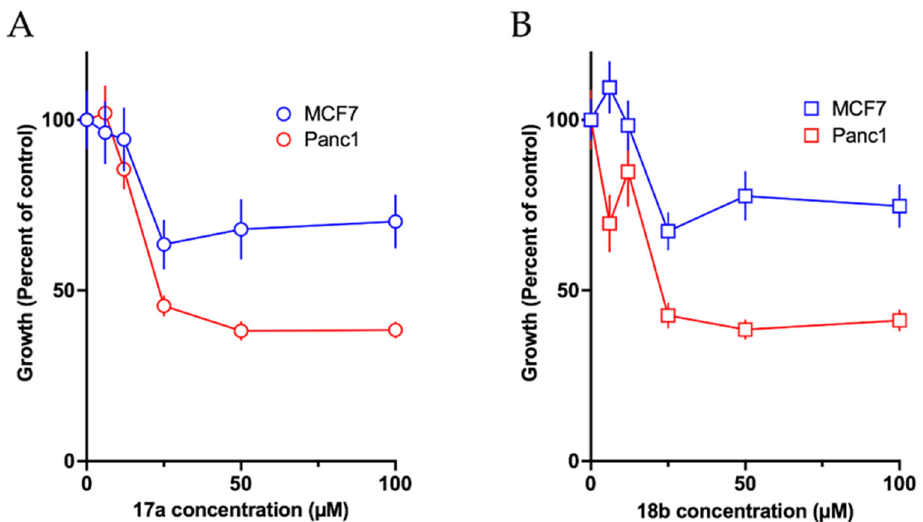
Figure 4. Effects of compounds 17a and 18b on the growth of Panc-1 and MCF-7 cells. ( A ) Compound 17a inhibited the growth of Panc-1 (red) and MCF-7 cells (blue) by approximately 50% at concentrations higher than 25 µ M. The inhibition of growth was stronger on Panc-1 cells. ( B ) Compound 18b showed a similar behaviour on both cell lines. Compound 18b inhibited the growth of Panc-1 cells more potently than MCF ‐ 7.